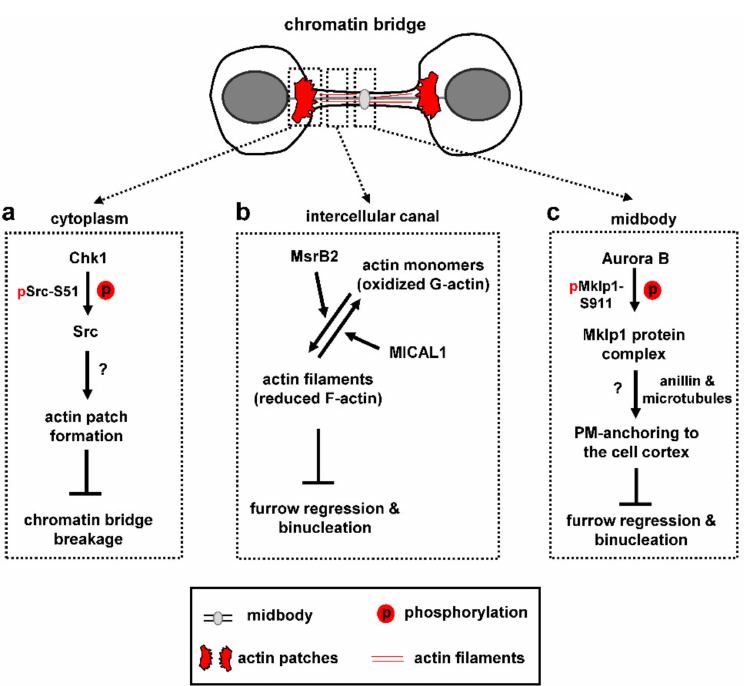
Figure 3. Stabilization of chromatin bridges and intercellular canals in mammalian cells. ( a ) Forma- tion of actin patches at the base of the intercellular canal prevents chromatin breakage. ( b ) MsrB2 reductase prevents depolymerization of actin filaments inside the intercellular canal. ( c ) Potential mechanism that promotes plasma membrane (PM)-anchoring to the cell cortex to prevent binucleation. p phosphorylation. Unknown molecular events are indicated by question